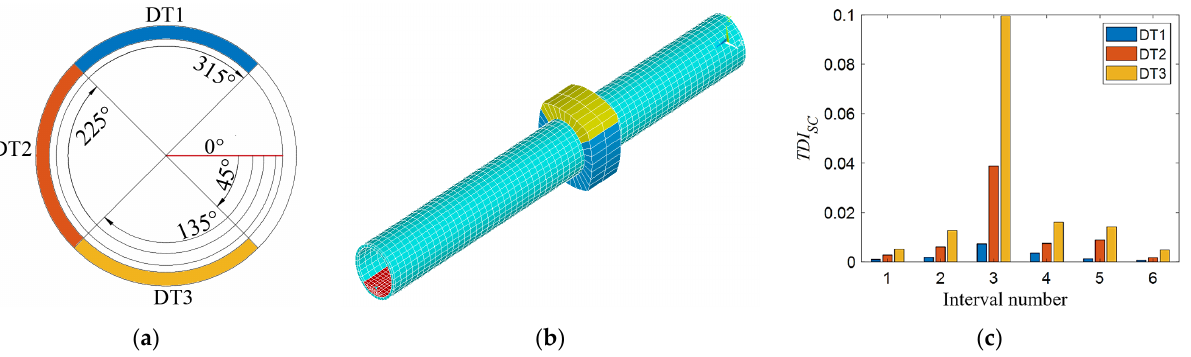
Figure 9. TDI SC index verification for single void damage in different directions: ( a ) schematic diagram of three different angles of voids on the cross section of the tunnel; ( b ) single void damage tunnel model in the third interval; and ( c ) TDI SC at different directions of single void